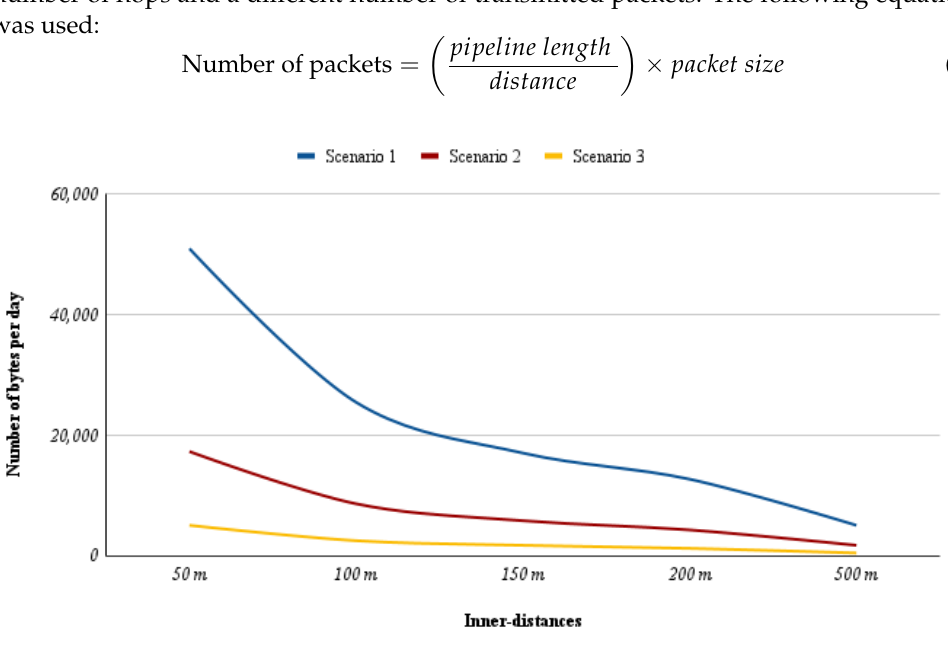
Figure 3. The number of bytes/days at different sensor distances (packet size is 255 bytes).